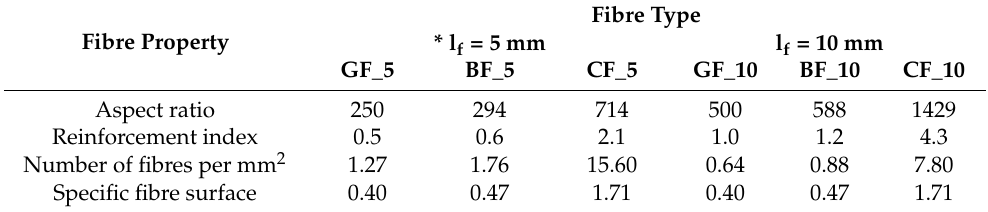
Table 2. Specific fibre characteristics calculated based on fibre properties.